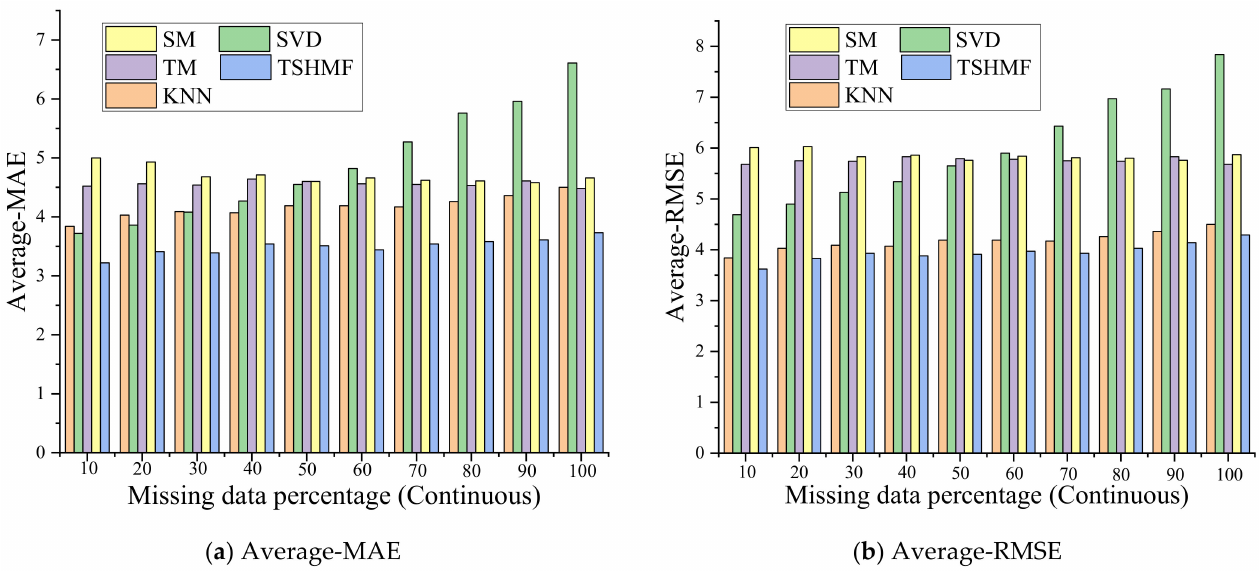
Figure 6. MAE and RMSE averages using different methods with 20 selected GNSS stations (missing ratio = 5 −